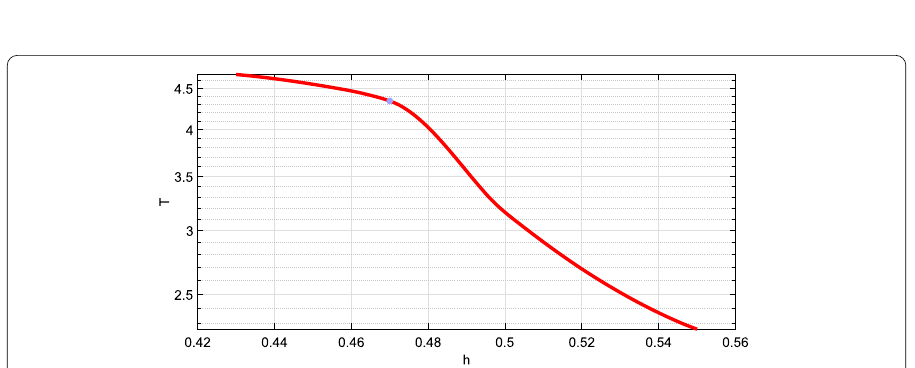
Figure 10 Impulse period T of the order one periodic solution varies with the economic threshold h